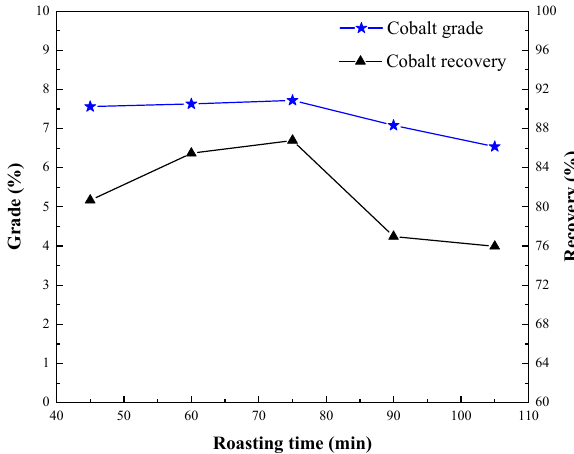
Figure 9. Effect of segregation roasting time on cobalt extraction.